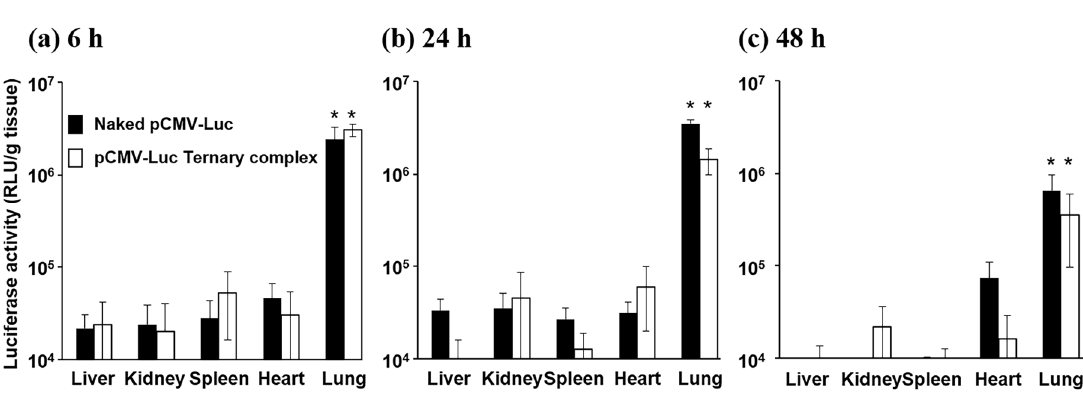
Figure 1. In vivo transfection experiments. Mice were administered naked pDNA or the pCMV-Luc ternary complex, sacrificed 6 ( a ), 24 ( b ), and 48 h ( c ) later, and the liver, kidneys, spleen, heart, and lungs were then dissected. Gene expression was assessed as luciferase activity. Data are the mean ± S.E. ( n = 3). * p < 0.05 (Tukey’s test).